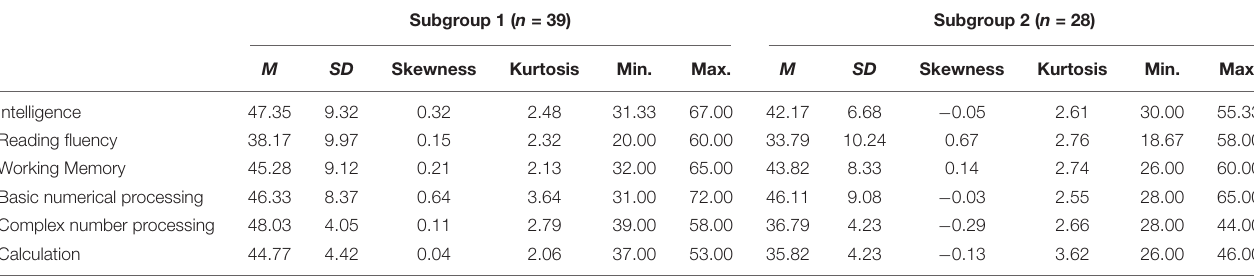
TABLE 2 | Descriptive statistics of the HRT sample—clustered by constructs.